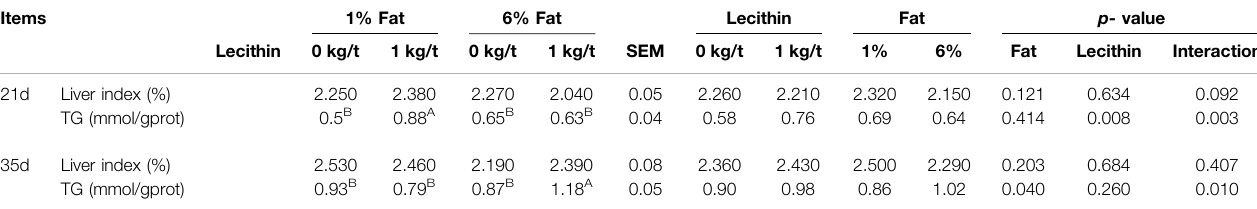
TABLE 5 | Effects of adding lecithin on layer Liver Index and TG content of liver in laying hens.